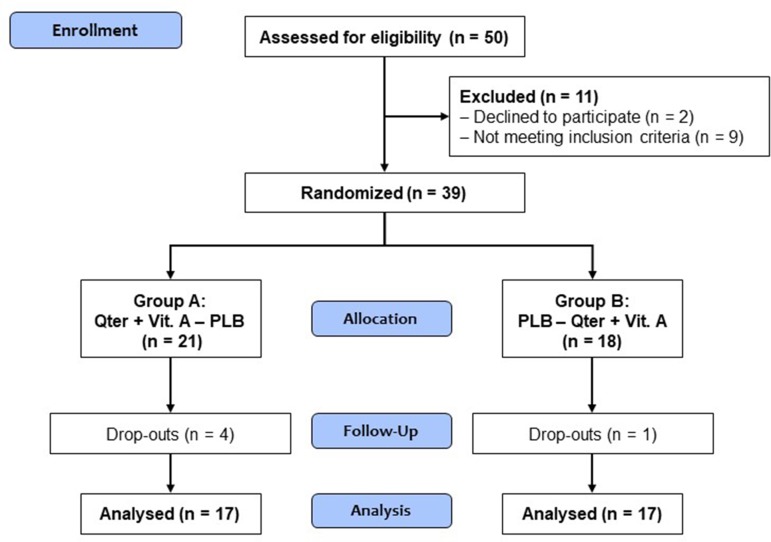
Study flow diagram.